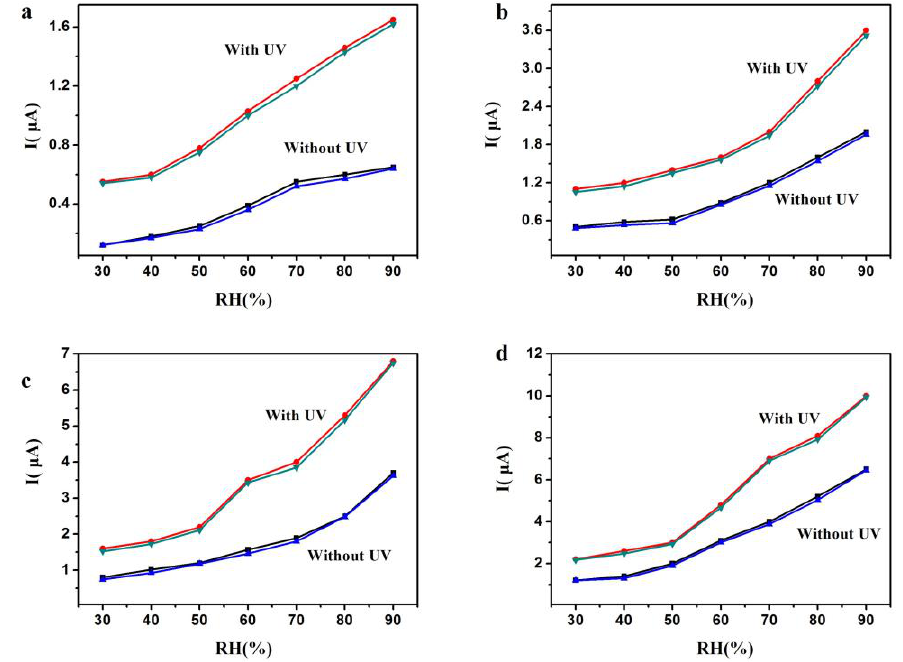
Figure 11. The humidity hysteresis measured for the sensors: ( a ) 1 V, ( b ) 2 V, ( c ) 3 V, and ( d ) 4 V.